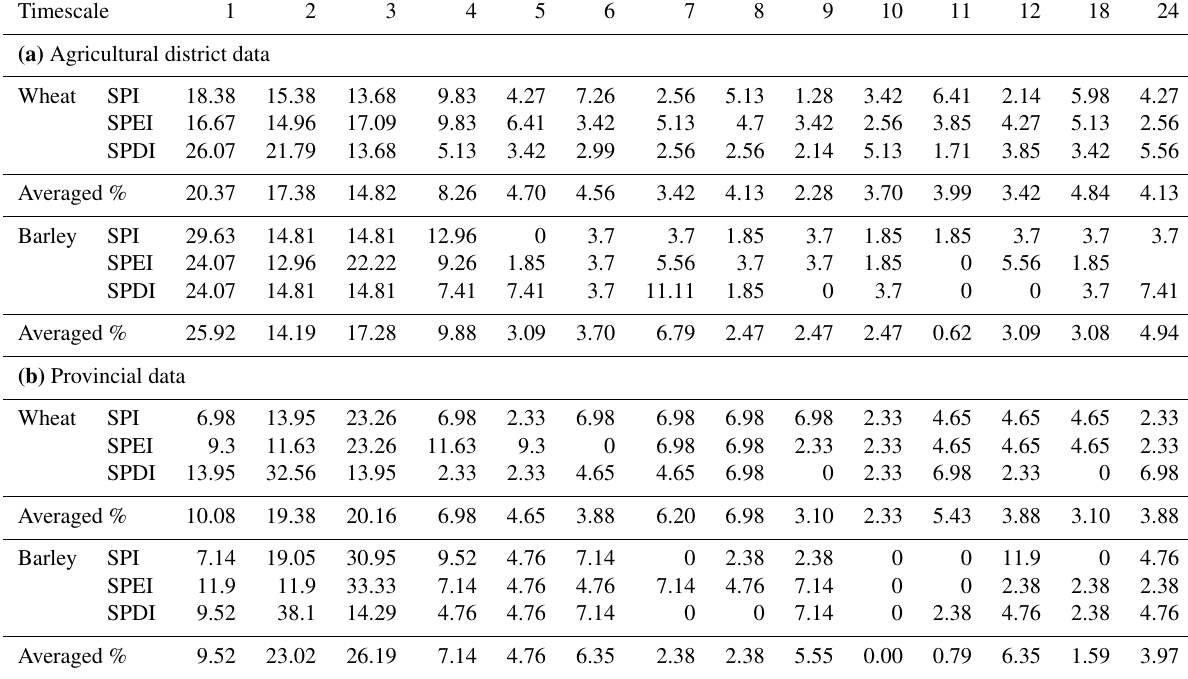
Table 1. Percentage of analyzed agricultural districts (a) and provinces (b) where wheat and barley are cultivated, for which the maximum correlations per timescale were found using the multi-scalar indices.